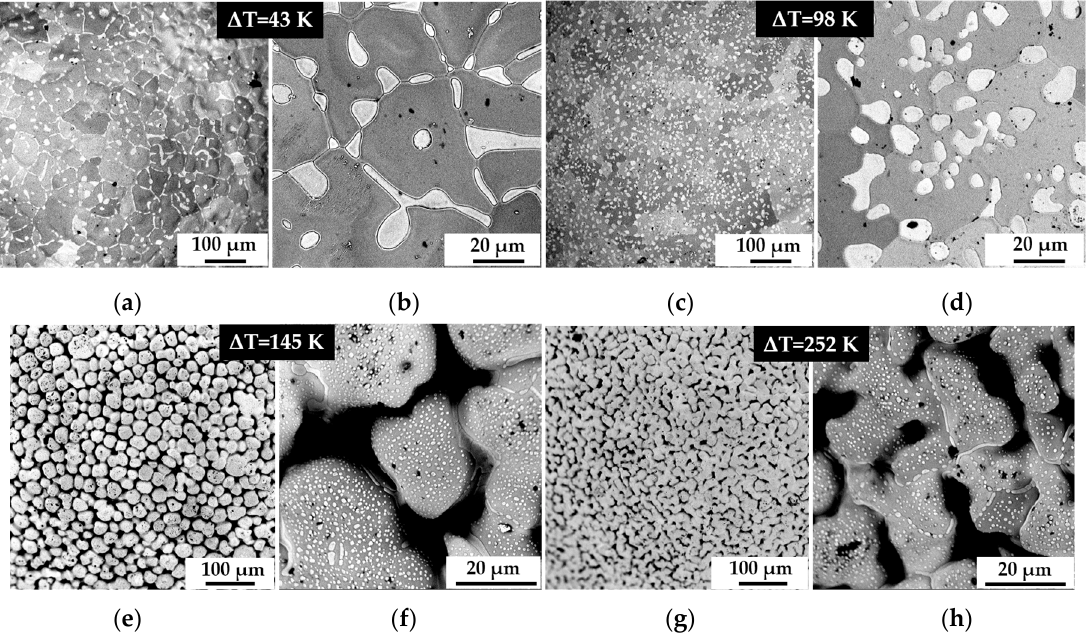
Figure 4. Back-scattered SEM micrographs for the surface of CoSi-62 at. % alloys processed (radiatively cooled) in the ESL. ( a , b ) Low ( Δ T = 43 K, Δ t = 4.57 s), ( c , d ) medium ( Δ T = 98 K, Δ t = ~0 s), ( e , f ) high ( Δ T = 145 K, Δ t = 12.13 s), and ( g , h ) high ( Δ T = 252 K, Δ t = 8.88 s) undercoolings.